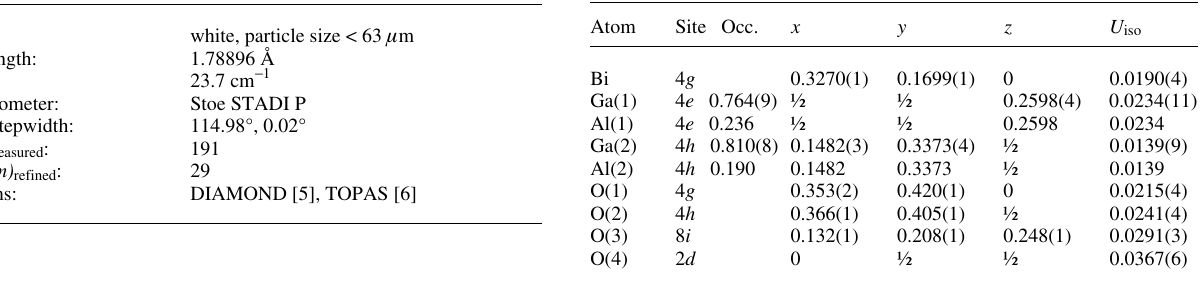
Table 5. Data collection and handling. Table 6. Atomic coordinates and displacement parameters (in Å 2 )